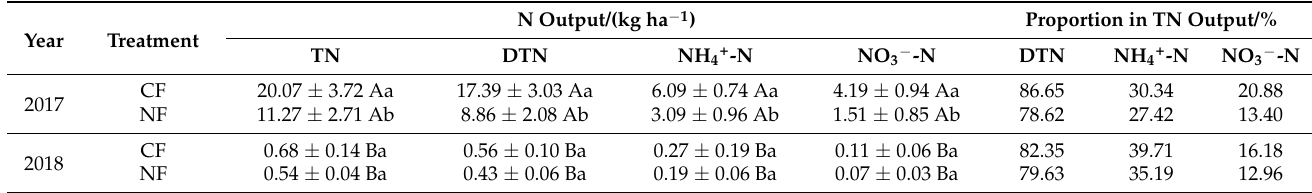
Table 4. Loss amount and rate of N via surface runoff in peanut-growing season.